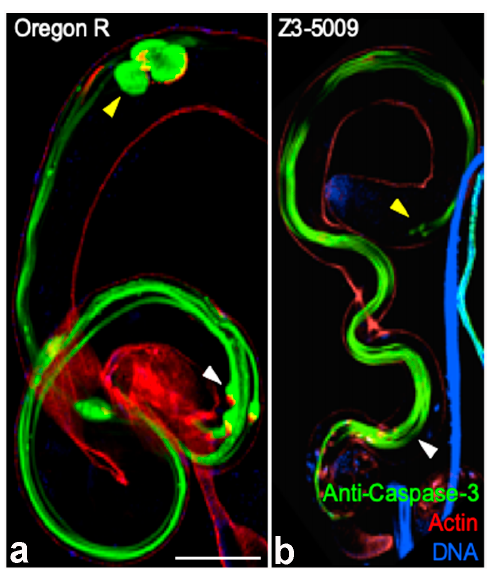
Figure 4. Activated caspase activity is normal in the Z3-5009 mutant. Activated caspases (green) are present throughout cysts in the Z3-5009 mutant ( b ), consistent with Oregon R ( a ). In control cysts, caspases accumulate in the cystic bulges (( a ), white arrowhead) and waste bags (( a ), yellow arrowhead). No cystic bulges (( b ), white arrowhead) or waste bags (( b ), yellow arrowhead) are seen in the Z3-5009 mutant, consistent with the observation that actin cones do not progress away from nuclei. Phalloidin staining, red; DAPI staining, blue. Bar 100 µ